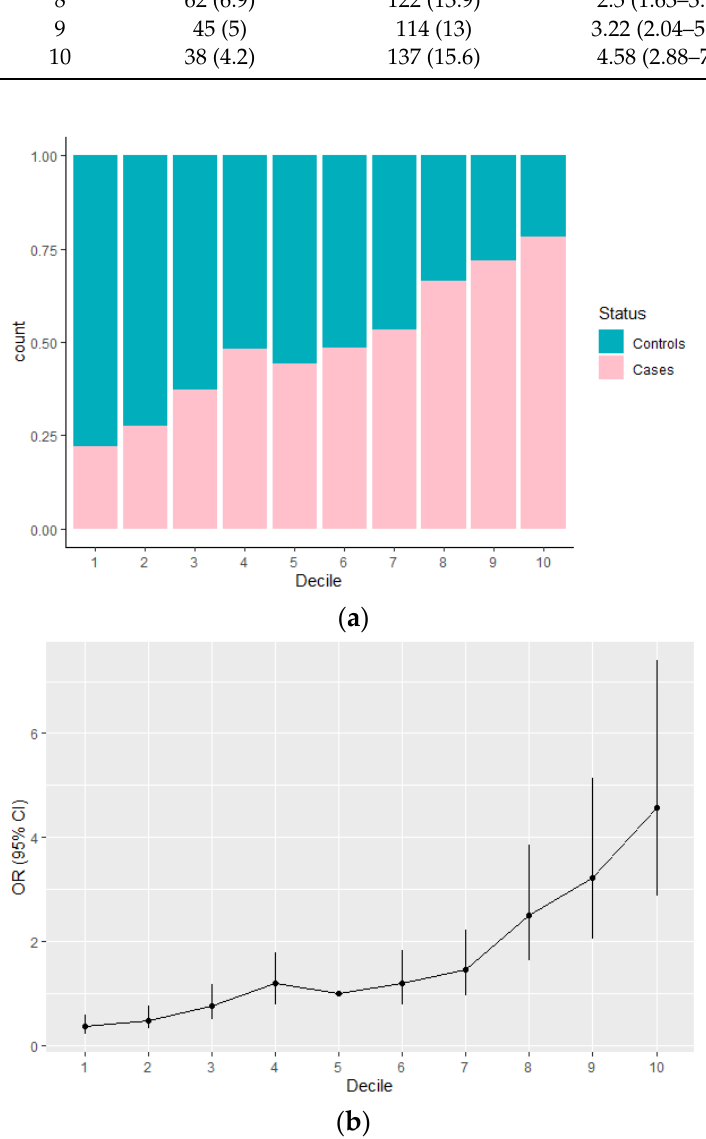
Figure 3. Association between the integrated risk model and breast cancer risk in the MASTOS study ( a ) Distribution of controls (blue) and cases (pink) of the MASTOS study in each decile, when the dataset was divided based on the predicted risk probability of the integrated risk model; ( b ) ORs (95% CI) by decile for breast cancer risk, using the 5th decile as the reference. Table 2. Total number of controls and cases of the MASTOS study included in each decile, when the dataset was divided based on the predicted risk probability of the integrated risk model. The estimated ORs (95% CI) of each decile for breast cancer risk were generated from logistic regression using the 5th decile as the reference.